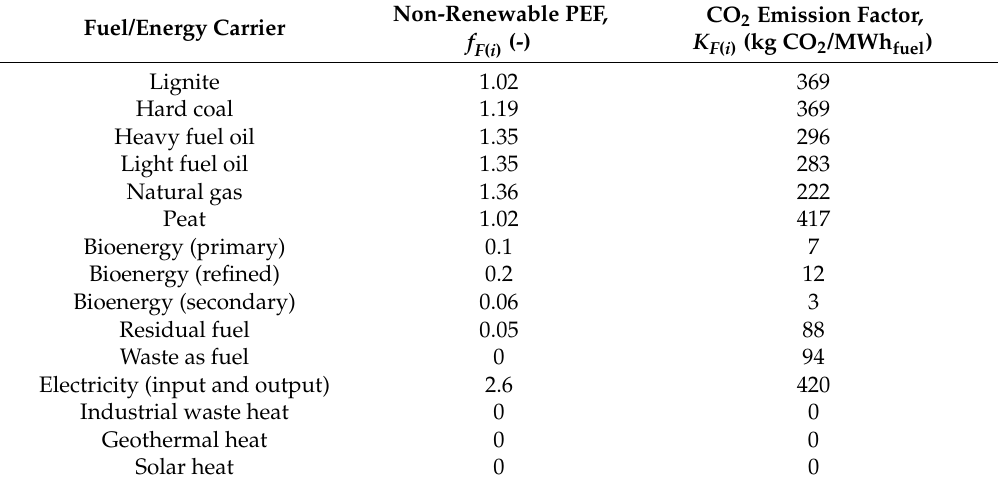
Table A3. Non-renewable PEF and CO 2 emission factors for fuels/energy carriers [113].